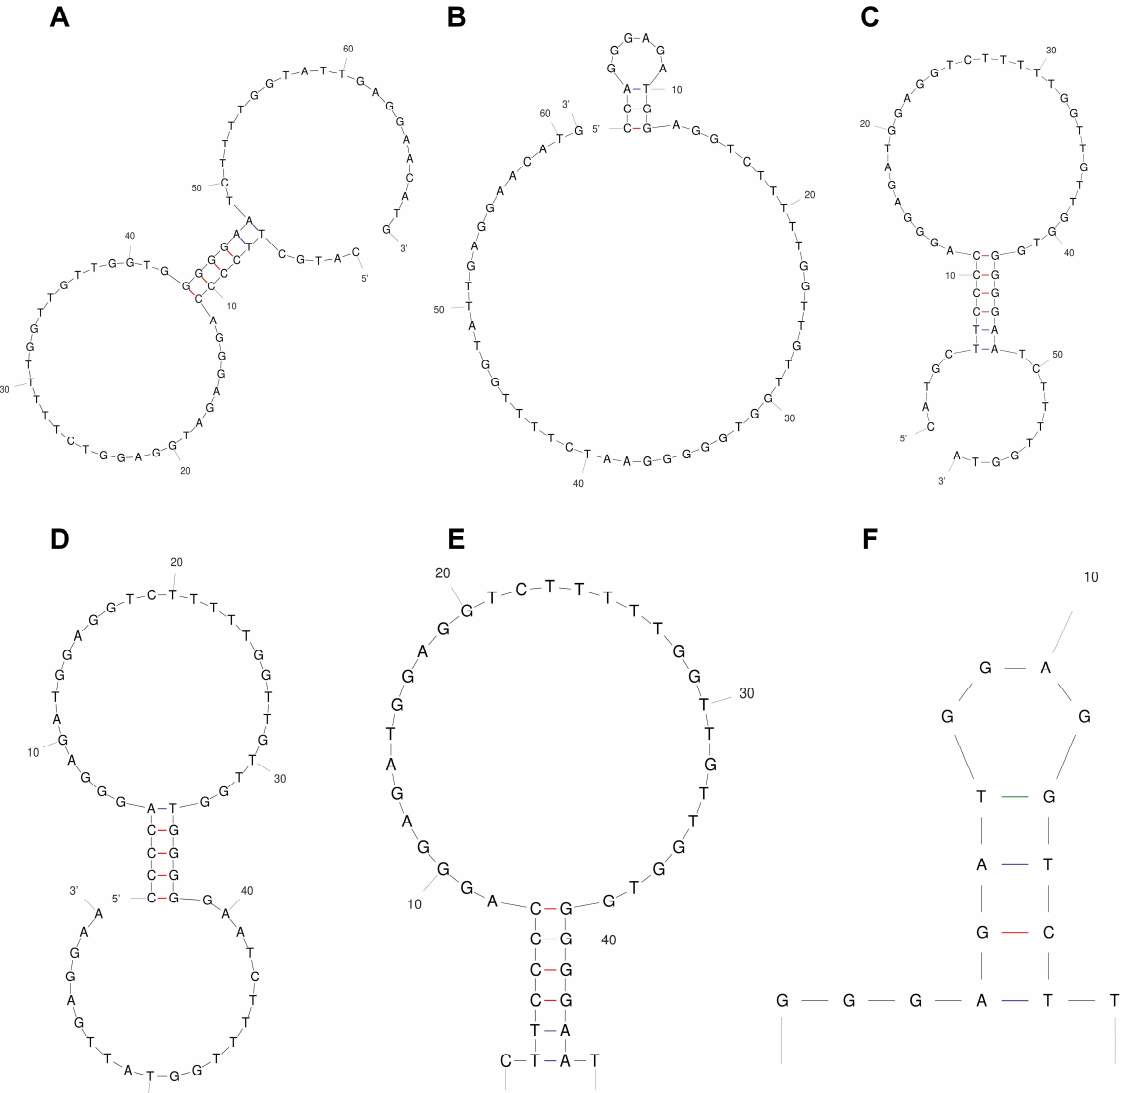
Figure 2. Secondary structures of the original α-amanitin aptamer and the truncated aptamer. The secondary structures of the aptamers were predicted and analyzed using Mfold software. ( A – F ) are Apt, Apt-2, Apt-8, Apt-10, Apt-11, and Apt-12.